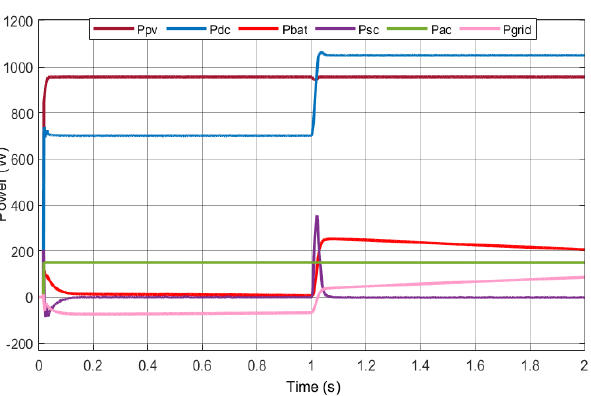
Figure 15. PV, DC load, AC load, supercapacitor, and battery power for change in load.